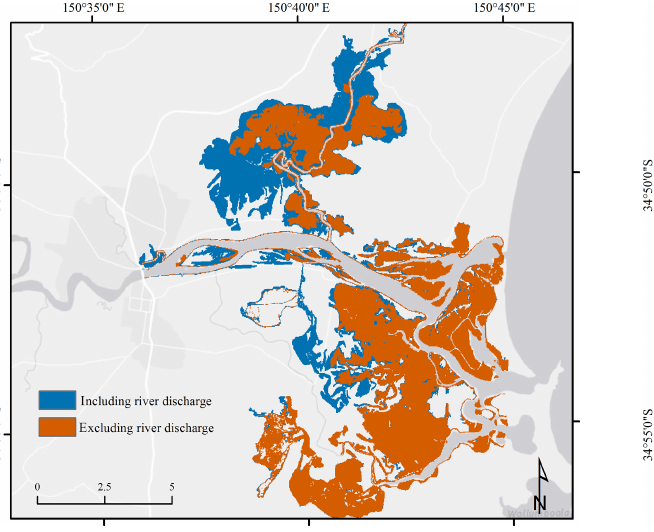
Figure 10. Map of modelled maximum flood extents resulting from simulations including and excluding river discharge using the two- open boundary model set-up. Flood extent of modelling including river discharge is indicated in blue, whereas the flood extent of mod- elling excluding river discharge is presented in orange.